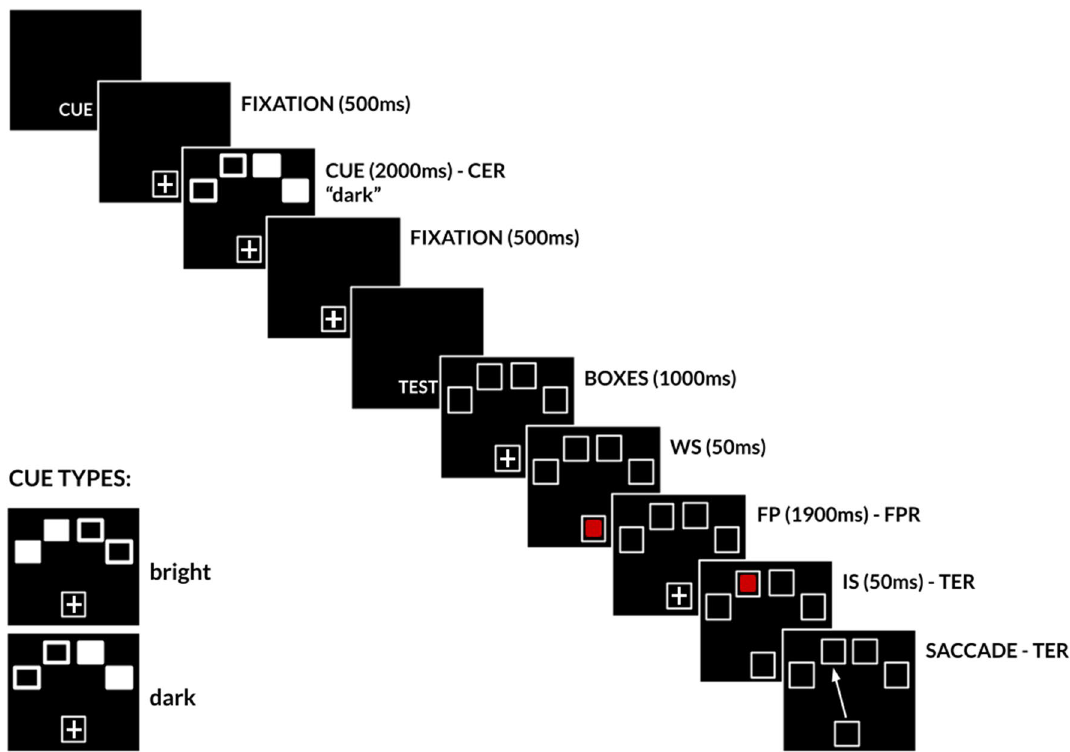
Figure 1. Schematic representation of the spatial surprise paradigm. During the cue interval, while maintaining gaze on the fixation cross , participants were presented with the spatial cue (cue boxes or CBs) on top of the screen. For half of the participants, CBs were represented as filled white squares (bright cue), for the other half open squares CBs were used (dark cue). CBs indicated the amount of expected surprise bounded to the future position of the target. Next, the warning stimulus (WS, first red square) was briefly presented in the fixation box . Extinction of the WS initiated a 1900 ms foreperiod (FP). Then the imperative stimulus (IS, second red square) was briefly presented in one of four test boxes (TBs). This event started the target-evoked response period (TER). Participants were asked to maintain gaze on the fixation cross during the FP and then make a visually guided saccade towards the IS as quickly as